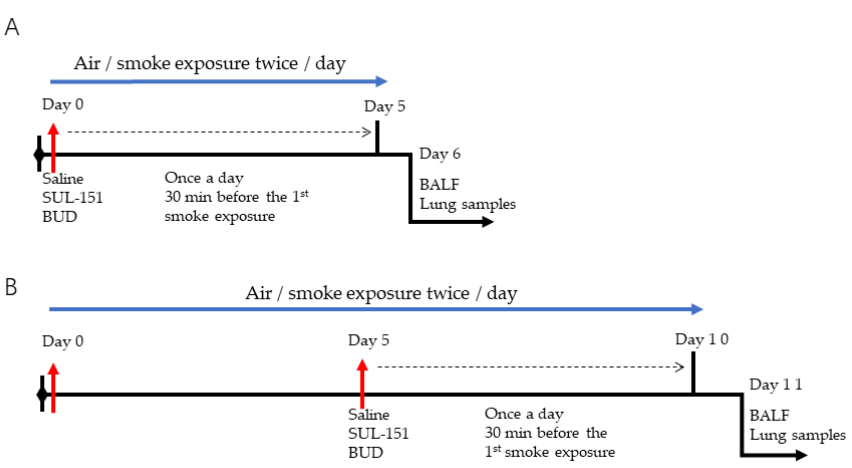
Figure 9. Schematic overview of the experimental design for the prophylactic treatment ( A ) and therapeutic treatment ( B ) of vehicle (saline), SUL-151, and budesonide (BUD) in the CS exposure model. The blue line represents the smoke exposure procedure (twice a day); the dotted line represents the saline, SUL-151, and BUD treatment (once a day, 30 min before the first round of smoke